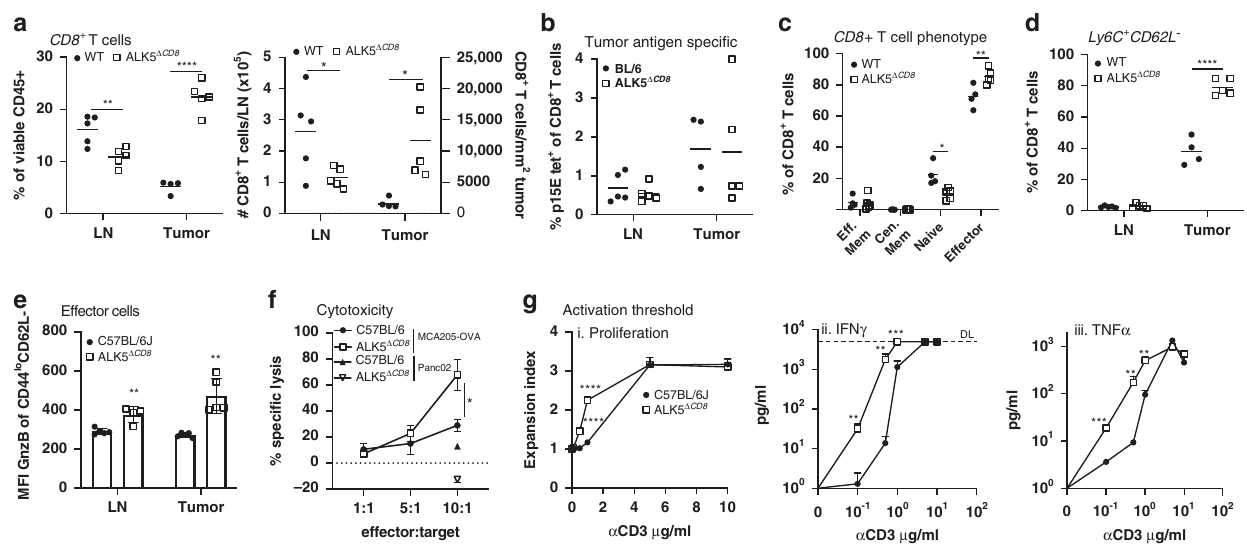
Fig. 3 ALK5 loss lowers the TCR activation threshold and enhances effector function of CD8 + T cells. For a – e : On day 14 following MC38 implantation into WT ( n = 6) and ALK5 Δ CD8 ( n = 5) mice, tumors were harvested, digested into a single cell suspension, and analyzed by fl ow cytometry. Each symbol is the value of an individual animal, measure of center is the mean. a Quanti fi cation of CD8 + T cells in lymph nodes and tumors by frequency (left). ** p = 0.00765, **** p = 0.000013. Absolute cell number in the lymph node or per mm 2 in the tumor (right). * p = 0.043 (LN) and 0.0172 (tumor). b The frequency of p15E tetramer positive CD8 + T cells determined by FACS analysis in lymph nodes and tumors of WT and ALK5 Δ CD8 mice. c The frequency of effector memory (CD44 hi /CD62L − ), central memory (CD44 hi /CD62L + ), naïve (CD44 lo /CD62L + ) or effector (CD44 lo /CD62L − ) CD8 + T cells. * p = 0.01, ** p = 0.0092. d The frequency of Ly6C + CD62L − CD8 + T cells in MC38 tumors or tumor draining inguinal lymph nodes from C57BL/6 or ALK5 Δ CD8 mice. **** p = 0.000046. e The median fl uorescent intensity of granzyme B (GnzB) expression gated on CD44 lo CD62L − CD8 + T cells in MC38 tumors, presented as mean + / − SD. ** p = 0.00316 (LN) and 0.0011 (tumor). f Speci fi c cytotoxic killing of tumor cells was measured with the Incucyte live cell imaging system in co-cultures of MCA205-OVA or Panc02 tumor cells with CFSE-labeled C57BL/6 WT and ALK5 Δ CD8 CD8 + T cells isolated from spleens of Δ actA-OVA vaccinated mice. Shown is the cumulative % dead tumor cells as determined by cytotox red reagent uptake of total tumor cells seeded following 24 h of co-culture presented as mean + / − SD. N = 3/condition. * p = 0.0344. g CD8 + T cells puri fi ed from spleens of naïve WT and ALK5 Δ CD8 mice and activated with increasing amounts of plate bound anti-CD3 and 10 μ g/ml anti-CD28. Presented as mean + / − SD. N = 3/condition (i) Proliferation index measured by CFSE dye dilution, **** p = 0.000015 and 0.000043. (ii) IFN- γ secretion, ** p = 0.00658 (10 − 1 ), 0.00924 (10 0 ), *** p